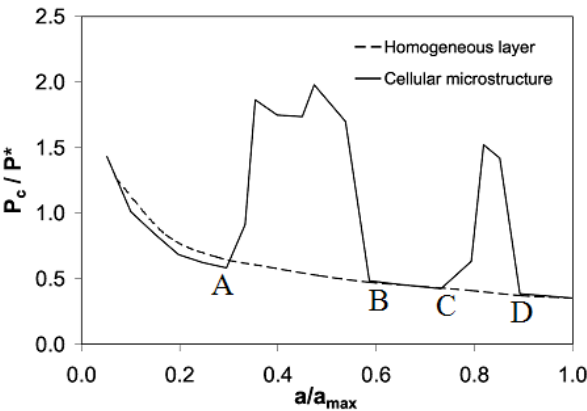
Figure 4: Dimensionless critical load for brittle crack propagation vs. dimensionless crack length. The response of a cellular microstructure is compared with that of a homogeneous layer.